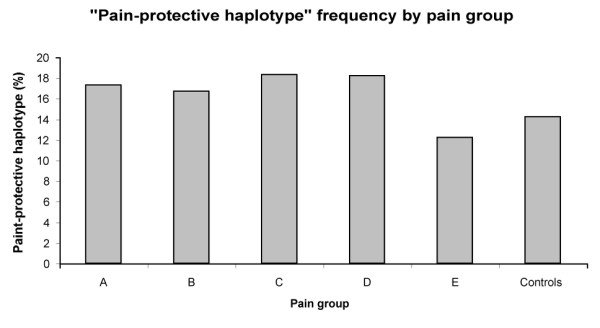
Pain-protective haplotype frequencies among pain groups. The frequency of the "pain protective haplotype" as percentage of total counts in the CP and RAP groups subdivided by the subject's response to the pain question. There was no significant difference between groups. "Pain protective haplotype" count: A = 20, B = 9, C = 46, D = 52, E = 10.